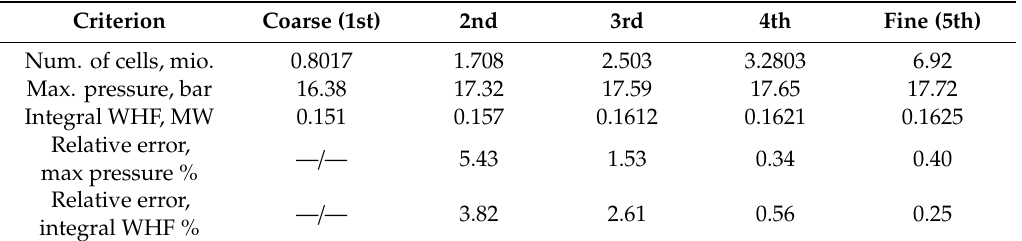
Table 1. Mesh independence study data.